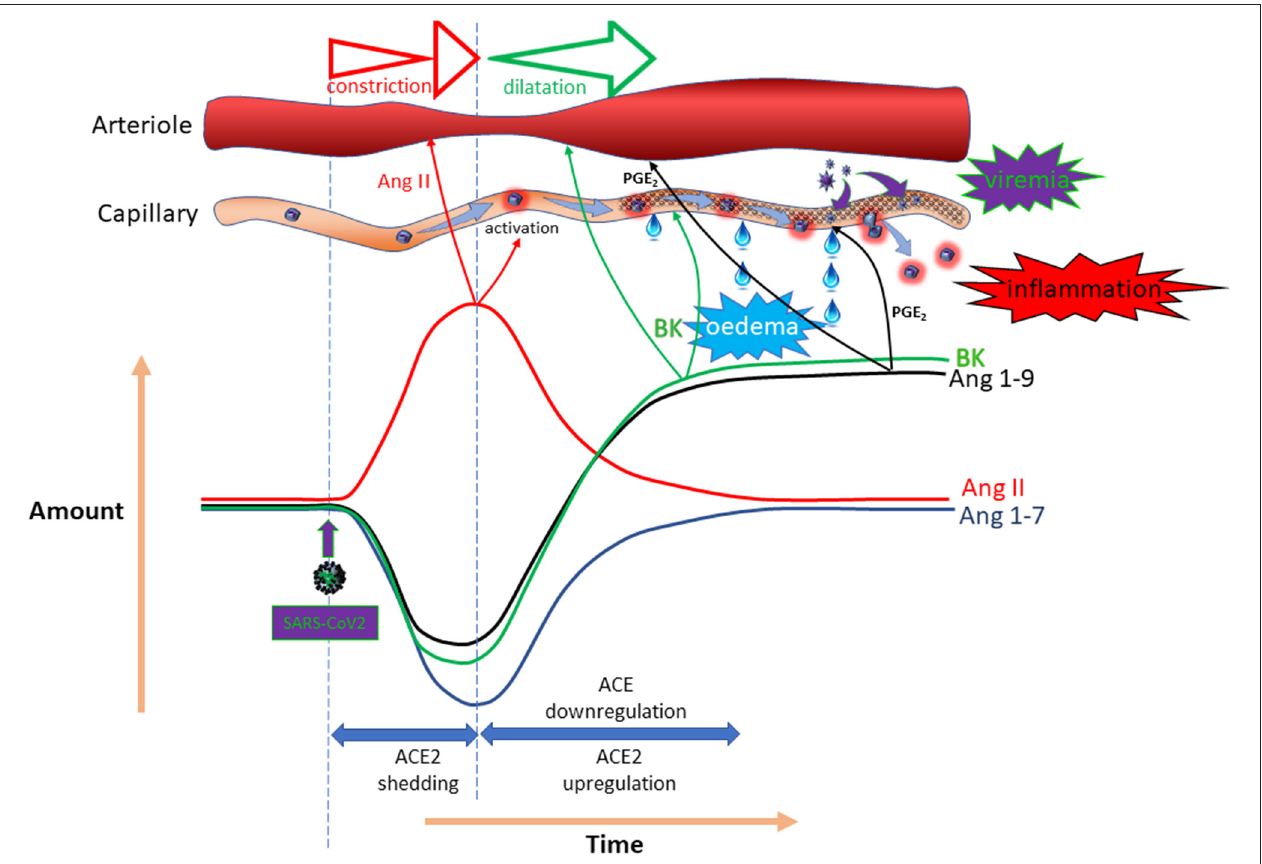
FIGURE 5 | Potential temporal impact of COVID-19 on the RAAS. Hypothetical impact of SARS-CoV-2 on local expression of ACE/ACE-2 enzymes and the possible outcome in terms of angiotensin-II, angiotensin 1–7, angiotensin 1–9 and bradykinin (BK) concentrations, as well as the vascular impact.